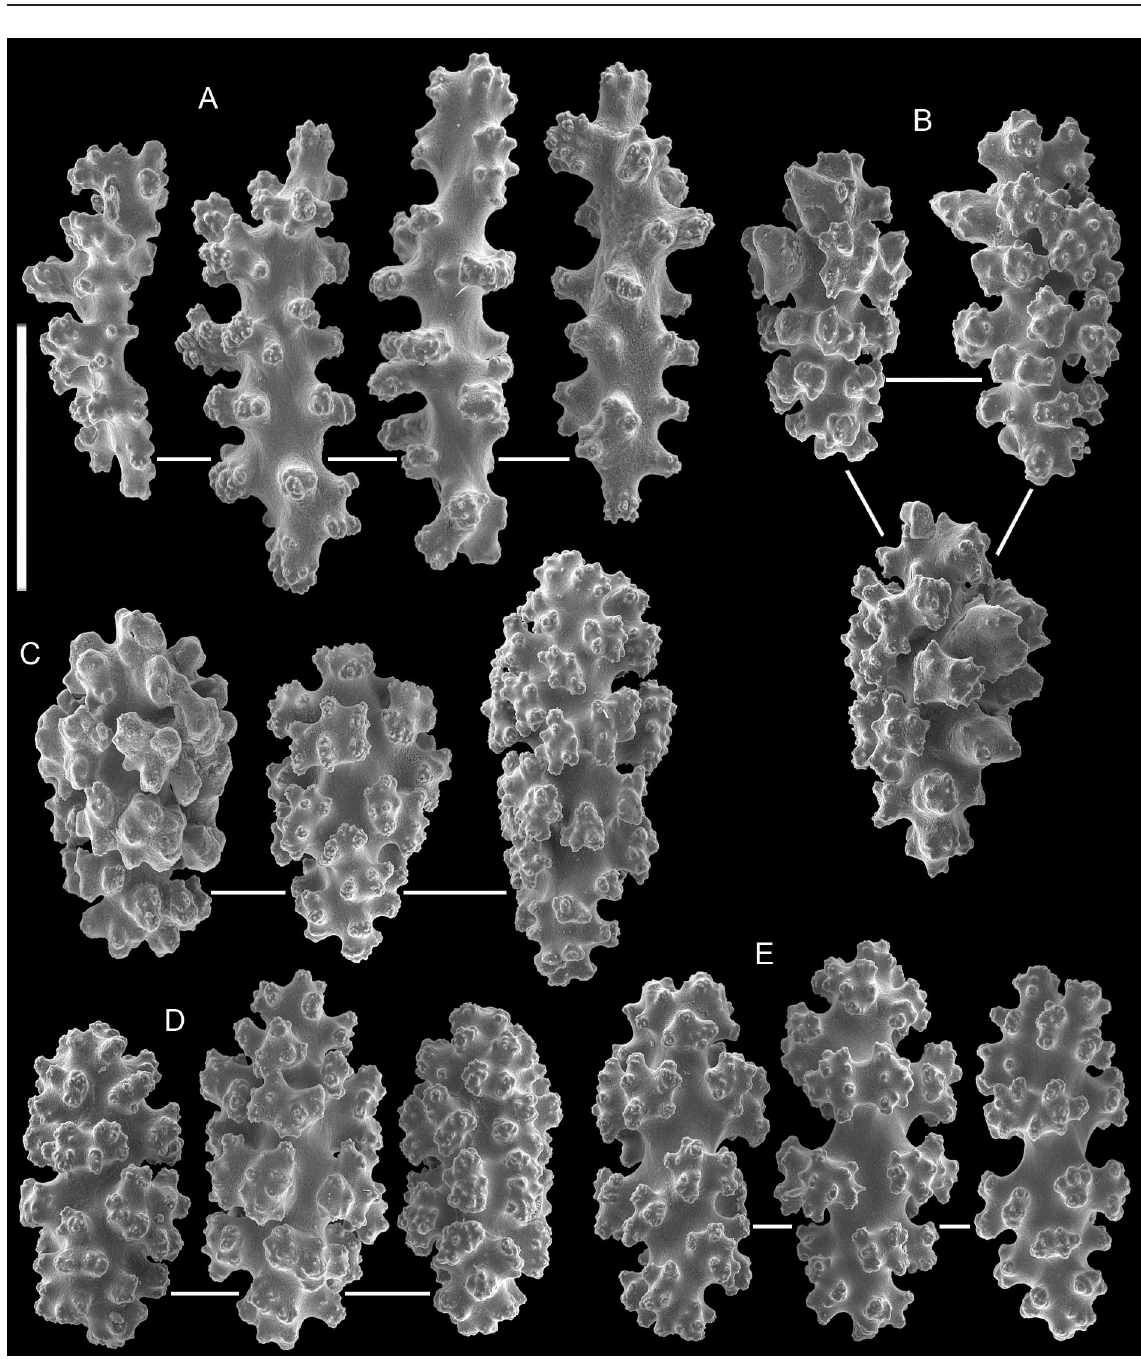
Fig. 11. Calcigorgia lukini sp. nov., paratype MIMB 20712, sclerites from the tentacles. A . Warty spindles from the tentacles. B . Clubs with leafy processes. C . Asymmetrical ovals. D . Symmetrical ovals. E . Capstans (8-radiate). Scale bar = 0.1